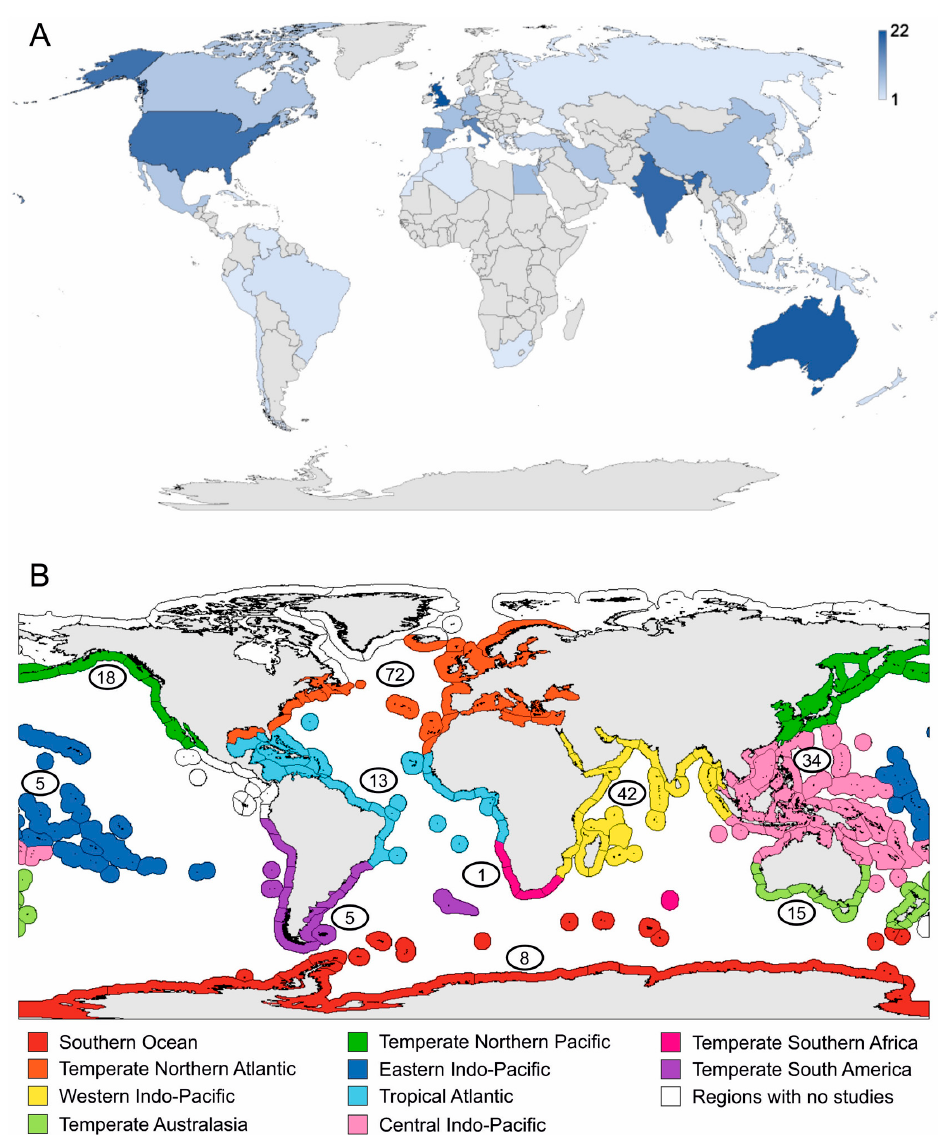
Figure 2. Map showing the number of documents per: ( A ) first authors’ affiliation country and ( B ) marine realm.